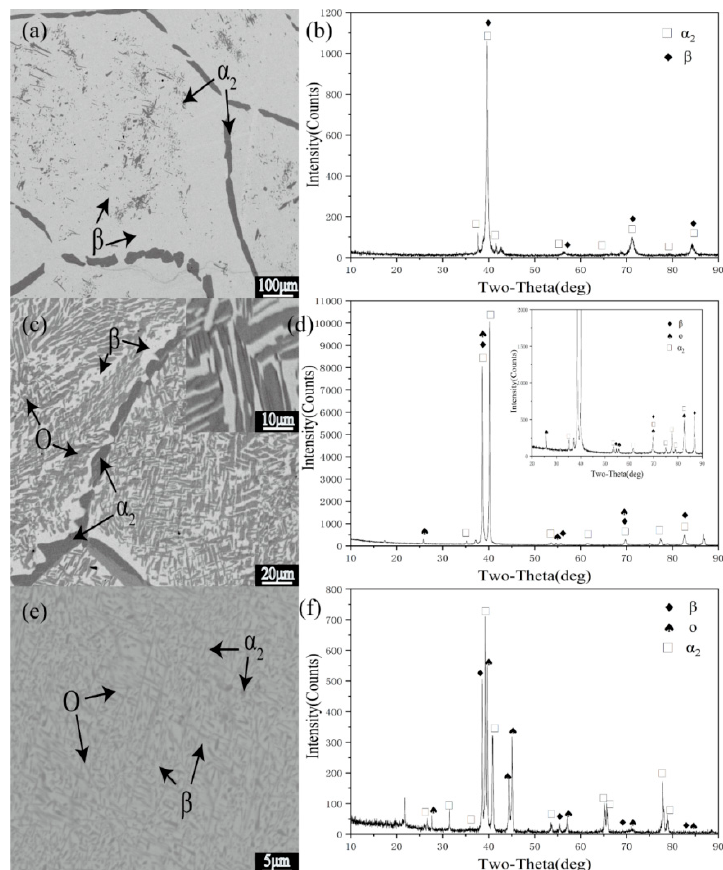
Figure 3. EPMA images and XRD results of alloy #4 after annealing at 1000, 900, 800 °C. ( a ) The microstructure of alloy #4 at 1000 °C; (b) the XRD result of alloy #4 at 1000 °C. ( c ) The microstructure of alloy #4 at 900 °C; ( d ) the XRD result of alloy #4 at 900 °C. ( e ) The microstructure of alloy #4 at 800 °C; ( f ) the XRD result of alloy #4 at 800 °C.